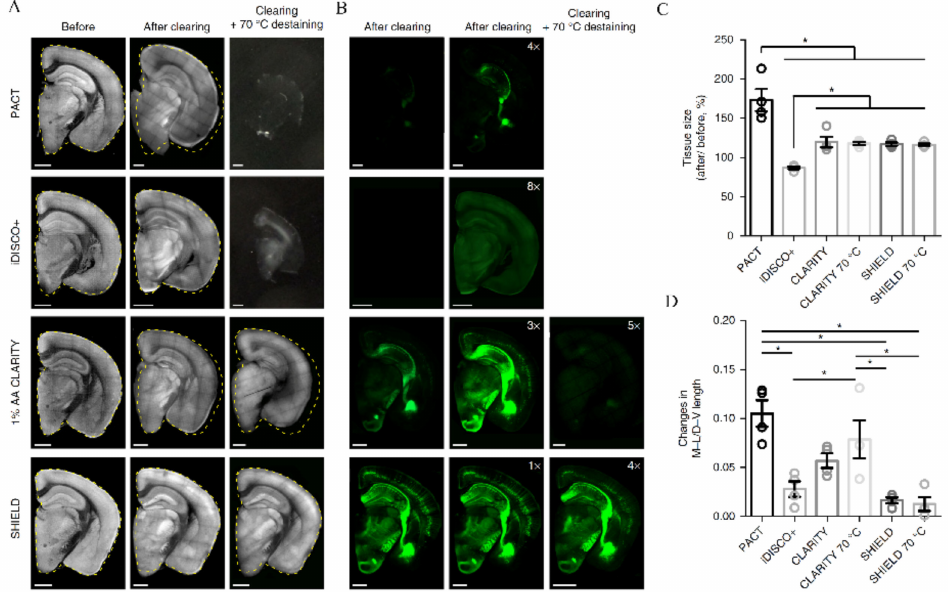
Figure 5. Tissue processing with SHIELD stabilizes its architecture and fluorescence. ( A ) Autofluo- rescence and ( B ) YFP images of 1-mm-thick mouse brain blocks confirm ( C , D ) excellent preservation of fluorescence and tissue size upon SHIELD processing. M-L/D-V length—measurement of medio- lateral and dorsoventral lengths of tissue blocks. Reproduced from Park et al. [79] with permission. * p <